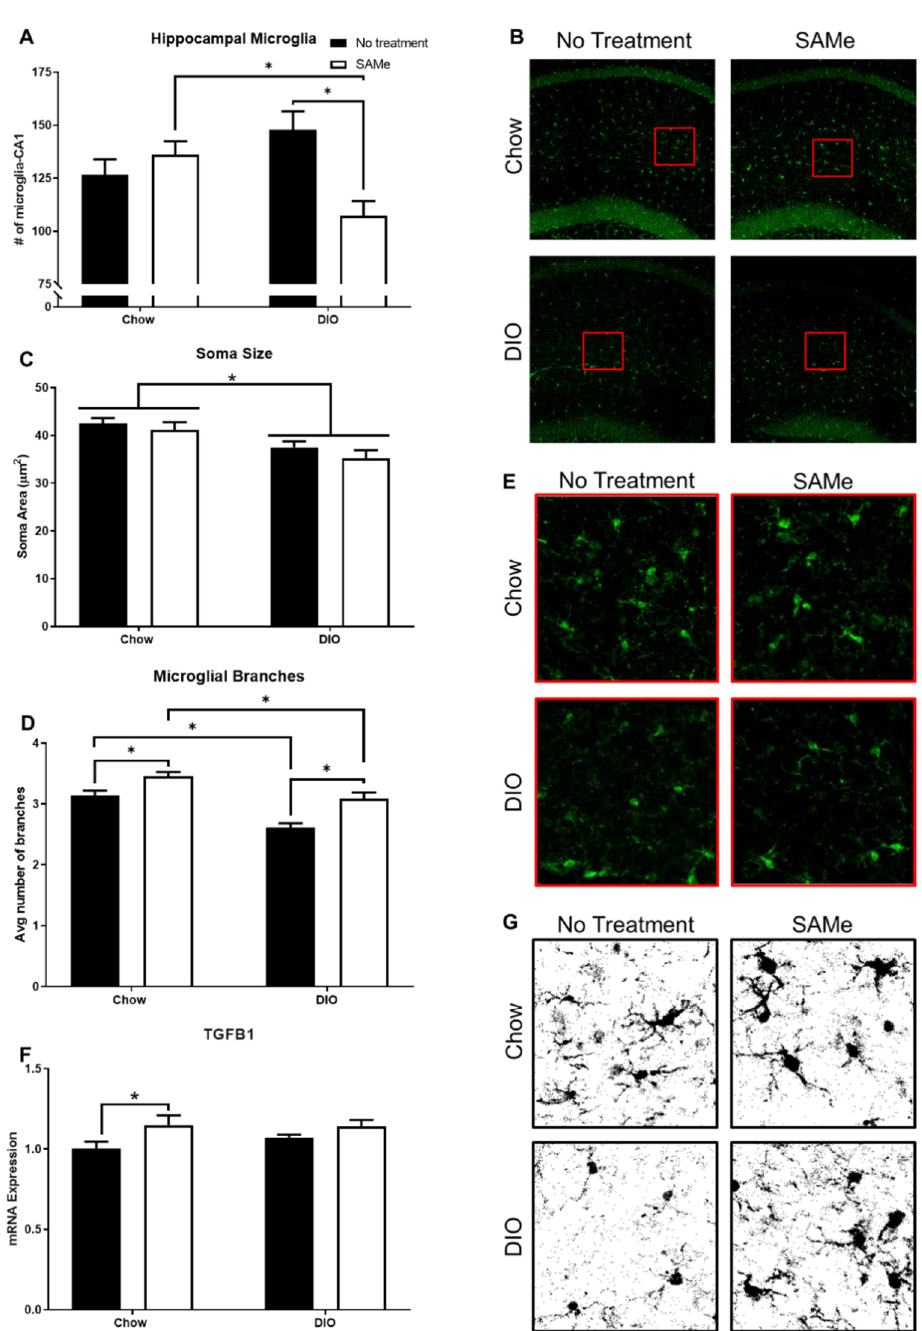
Figure 3. Hippocampal microglia were quantified within the sub-pyramidal area of CA1 for each condition ( n = 5–7/group). ( A ) SAMe treatment in DIO mice significantly reduced microglia density within the CA1, compared to Chow + SAMe and untreated DIO counterparts. ( B ) Representative confocal images of hippocampal microglia. ( C ) Somal area of microglia were measured. DIO significantly reduced the cell body size of microglia. ( D ) Representative confocal images of microglial morphology. ( E ) Both DIO and SAMe affected the number of microglia branches. ( F ) Representative high contrast images. ( G ) Transforming Growth Factor beta 1 (TGFb1) was measured by qPCR ( n = 4–5/group) using hippocampal samples. SAMe treatment significantly increased TGFb1 expression in Chow mice. *: Significant